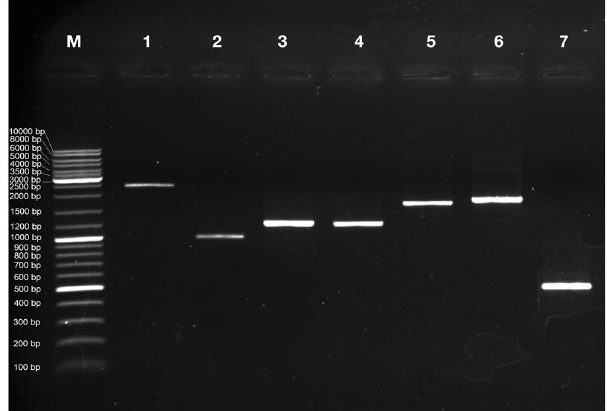
Figure 9. Reverse Transcription PCR analysis of selected unigenes of Solanum trilobatum leaf transcriptome. M is GeneRuler DNA ladder mix (Thermo Fisher Scientific, Waltham, MA), Lane 1–7 are amplicons of Phenylalanine ammonia lyase (2396 bp), Chalcone isomerase (998 bp), Flavonol synthase (1227 bp), Naringenin 3-dioxygenase (1215 bp), Coumaroylquinate 3 ′ -monooxygenase (1673 bp), Squalene monooxygenase (1785 bp) and Actin (480 bp) respectively.